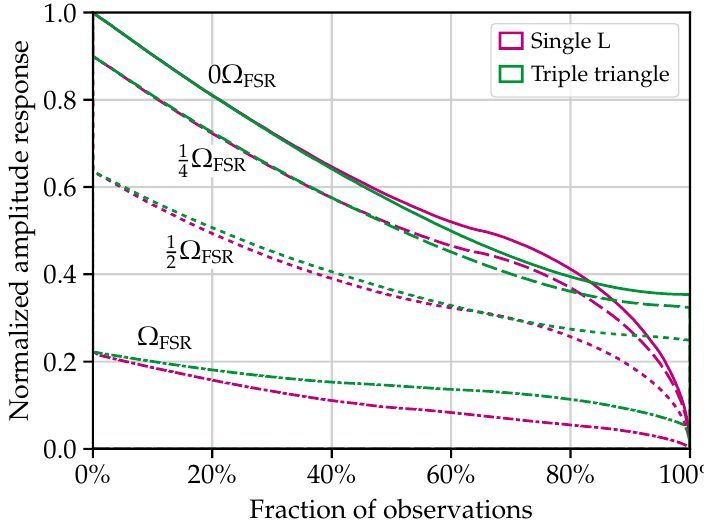
Figure 4. Histogram of normalized, polarization-averaged antenna patterns for a single L-shaped interferometer (such as Cosmic Explorer) and a three-detector triangle (such as the Einstein Telescope), assuming sources distributed isotropically on the sky. Curves are shown for gravitational waves at frequencies 0, 1 , 1 and 1 times the detector free spectral range Ω FSR /2 π = c /2 L . Note that 2 4 (cid:14) Ω ( CE ) = Ω ( ET ) 4. FSR FSR